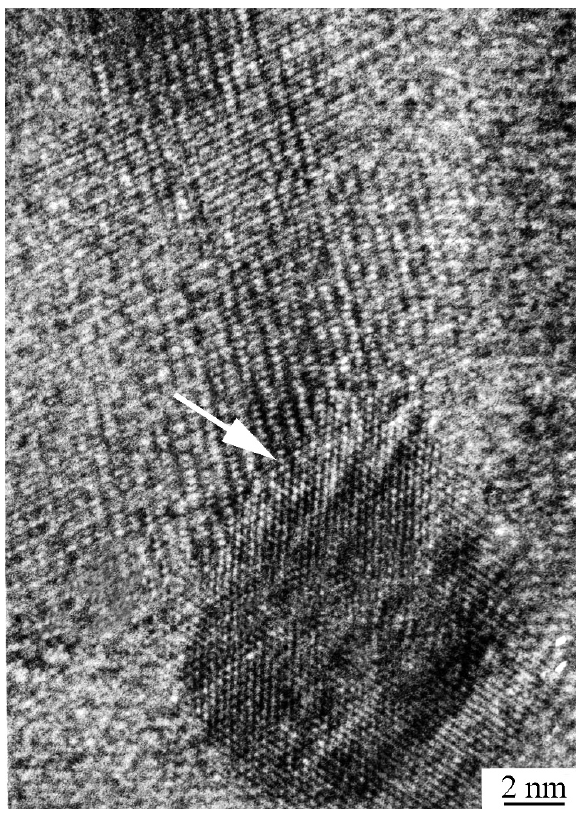
Figure 4. High ‐ resolution image of the structure of annealed (Ni65Mo35)90B10 sample under the decomposition of the nanocrystalline structure. An arrow marks the region of a direct contact of the nanocrystals with each other.